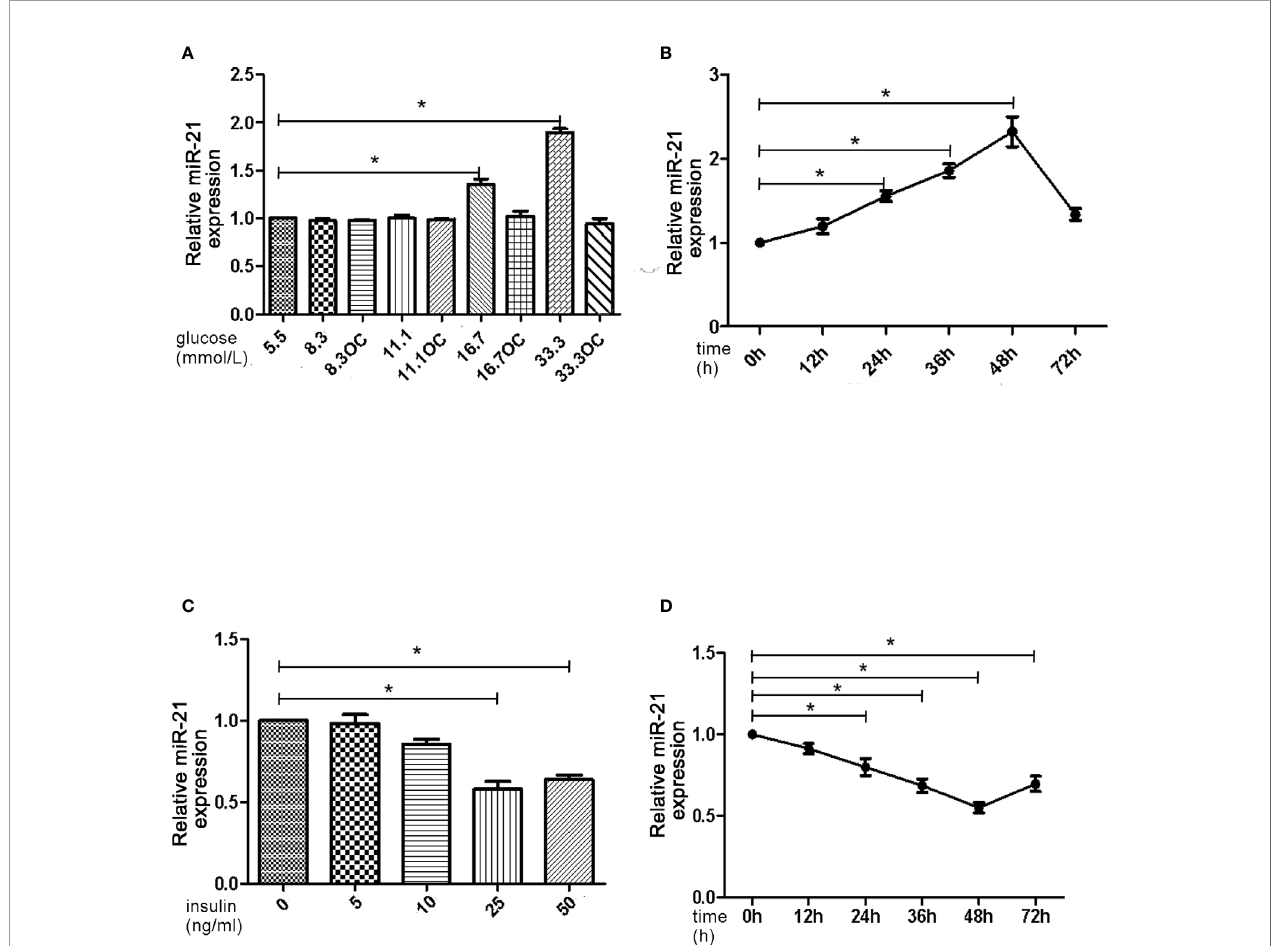
FIGURE 1 | High insulin and glucose concentrations have opposite effects on the expression of miR-21. (A) : qRT-PCR analysis of miR-21 in HGECs after treatment with different concentrations of glucose for 48 h. (B) : qRT-PCR analysis of miR-21 in HGECs treated with 33.3 mmol/L glucose for different periods of time. (C) : qRT-PCR analysis of miR-21 in HGECs after treatment with different concentrations of insulin for 48 h. (D) : qRT-PCR analysis of miR-21 in HGECs treated with 50 ng/mL insulin for different periods of time. Data are presented as means ± SD, *P < 0.05. All data are representative of three independent experiments. OC, osmotic control. qRT-PCR, quantitative real-time polymerase chain